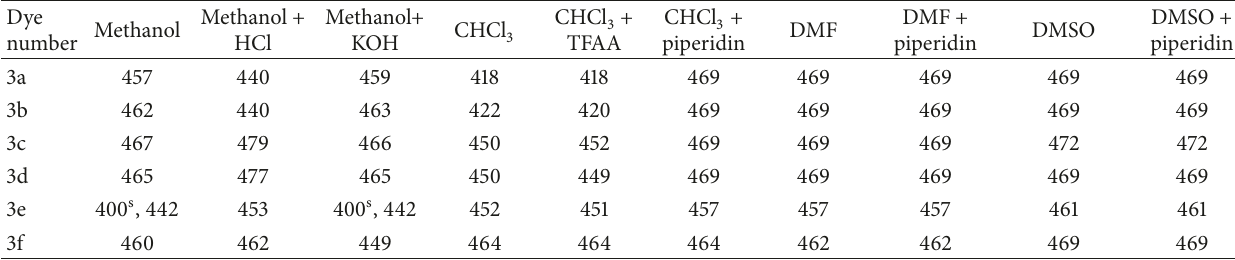
Table 5: Absorption maxima of dyes in acidic and basic